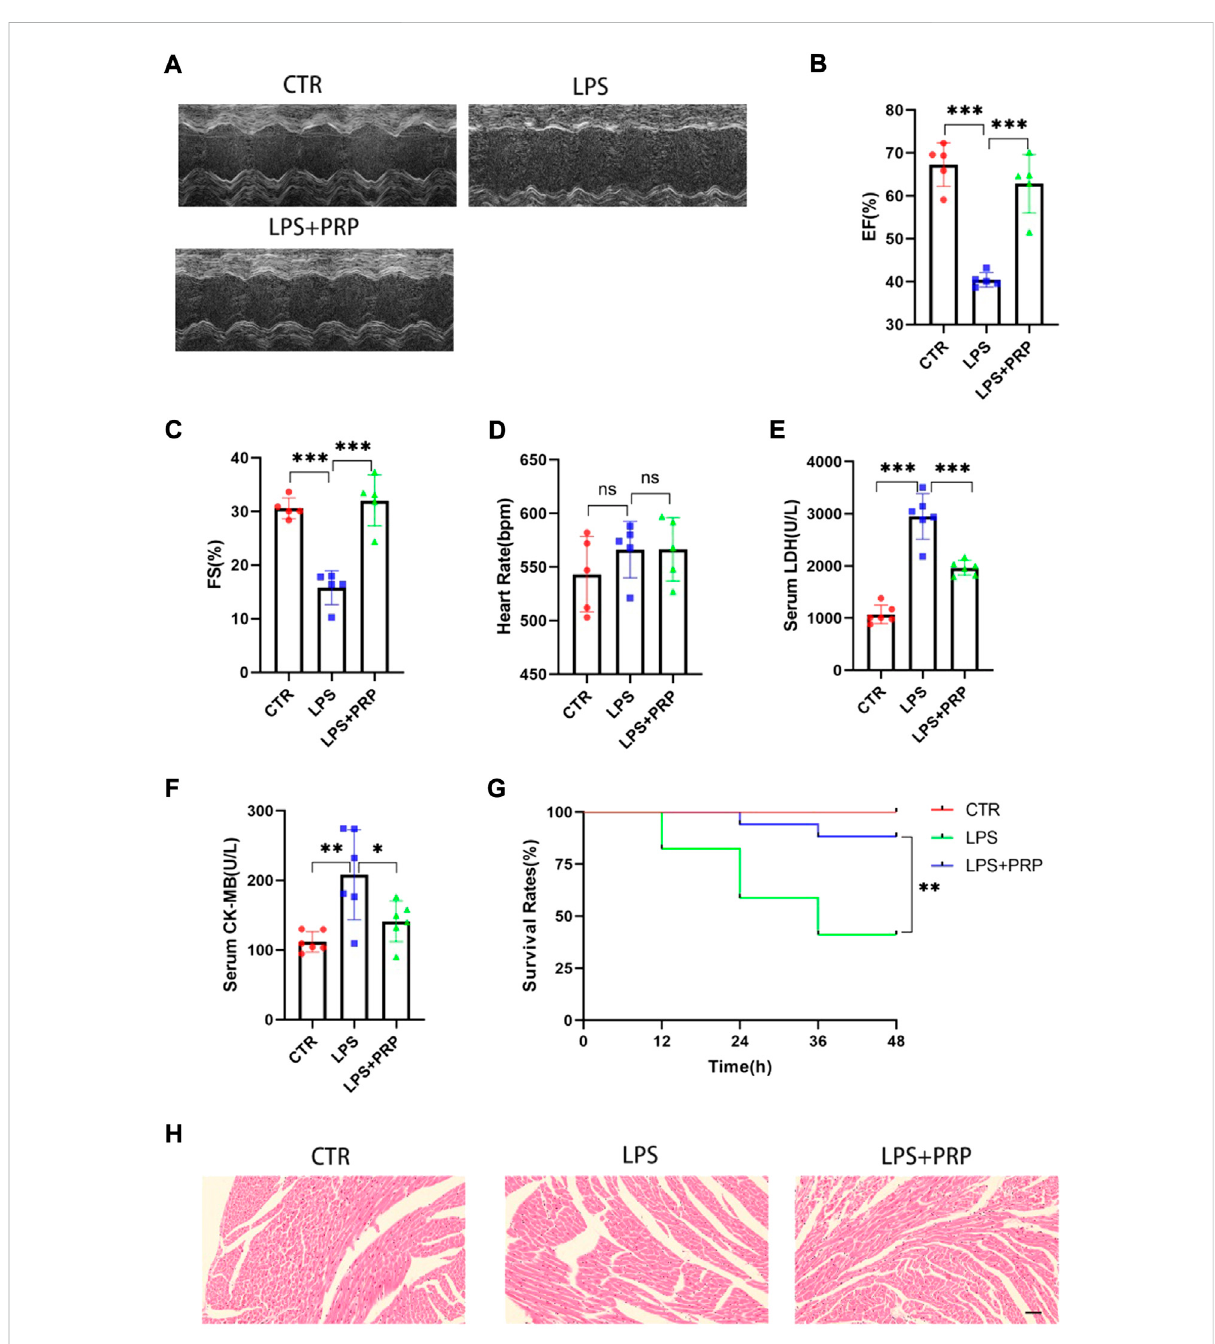
PRP alleviated LPS-mediated cardiac injury. (A) Representative images of M-mode echocardiogram. (B – D) The ejection fraction (EF), fractional shortening (FS),andheartrateofmice( n =5). (E) and (F) ThelevelsofLDHandCK-MBinserum ( n =6). (G) Thesurvivalrateofmiceinjected withPBS (30 µL), LPS (15 mg/kg), and LPS + PRP (30 µL) ( n = 17 per group). (H) H&E staining in hearts compared with LPS and different groups (scale bar = 50 μ m). * indicates p < 0.05. ** indicates p < 0.01. *** indicates p < 0.001. ns indicates p >